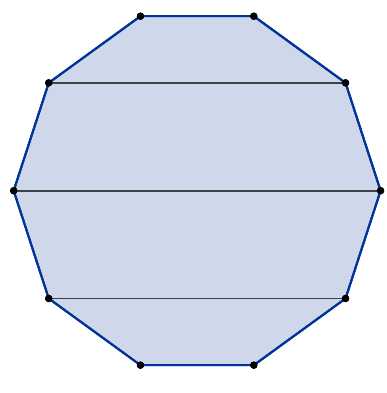
Figure 11 . Dissection (14 , 510 , 69) .